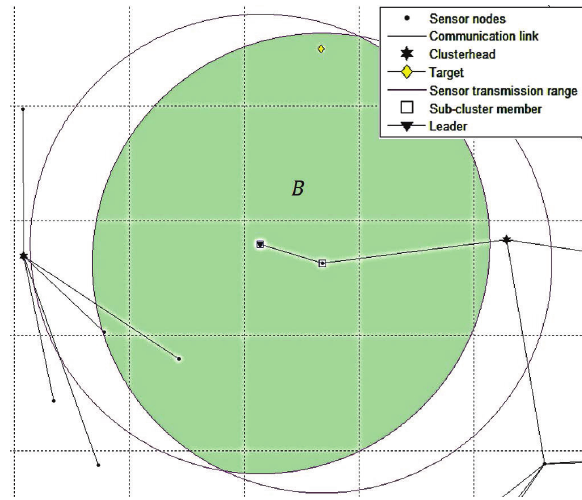
Figure 7. The bounding area B of